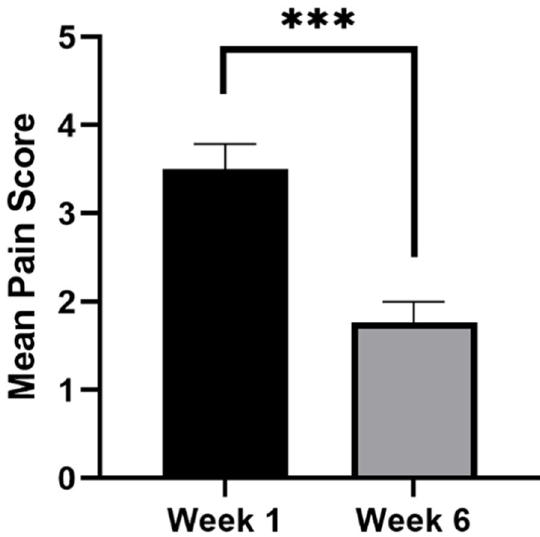
Fig. 3 Change in pain level from intake to exit as reported on a self-report pain journal. Subjects were asked to rank their pain each morning on a scale from 0 is equal to no pain and 5 is equal to the worst possible pain. Ordinate: Mean score on the pain journal. Abscissa: scores at week 1 versus scores at week 6. Significance was determined using the pairwise t -test. *** p < 0.001. Error bars represent the standard error of the mean (SEM)